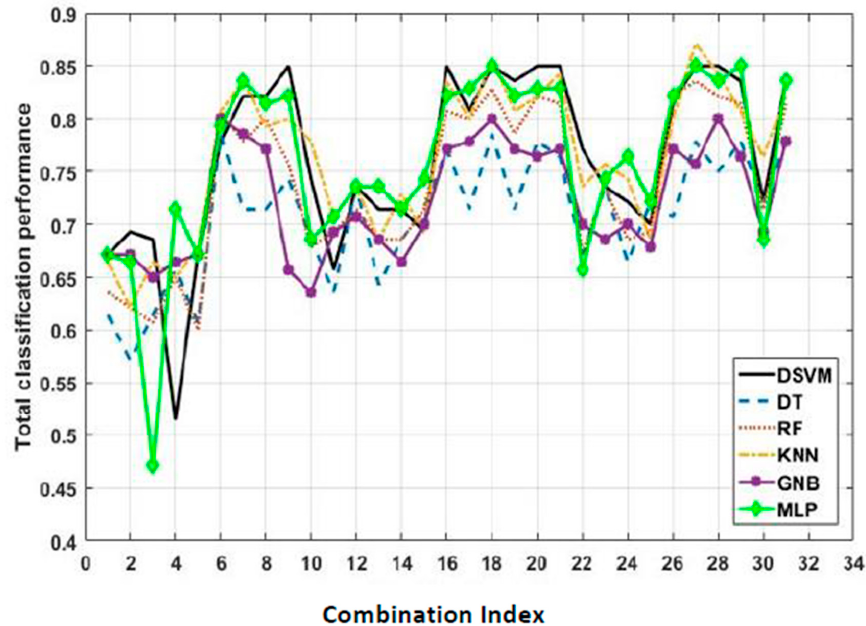
Figure 8. Total classification accuracy versus combination index for classifying cardboard from the rest for di ff erent classification approaches using LOO